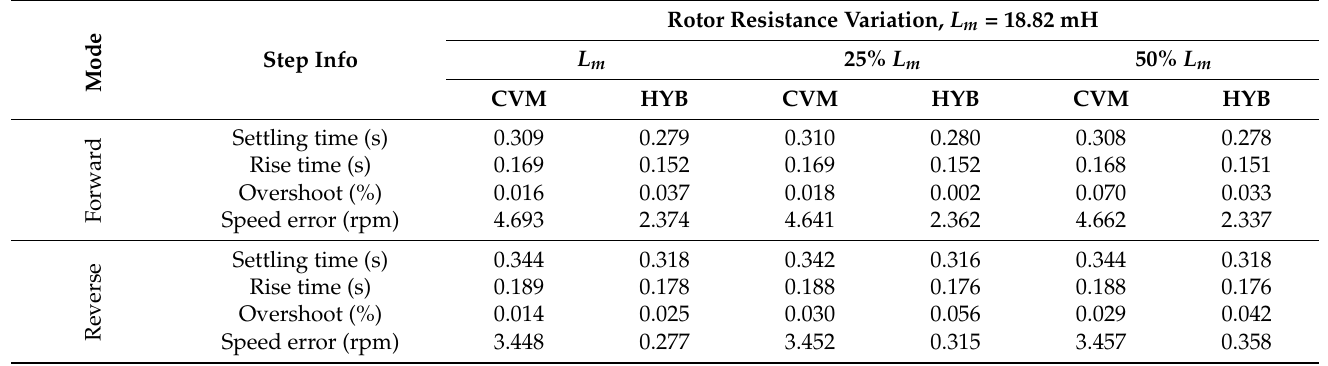
Figure 14. Rotor speed response against mutual inductance variation: ( a ) in forward operation and ( b ) in reverse operation. Table 4. Rotor speed performance under mutual inductance